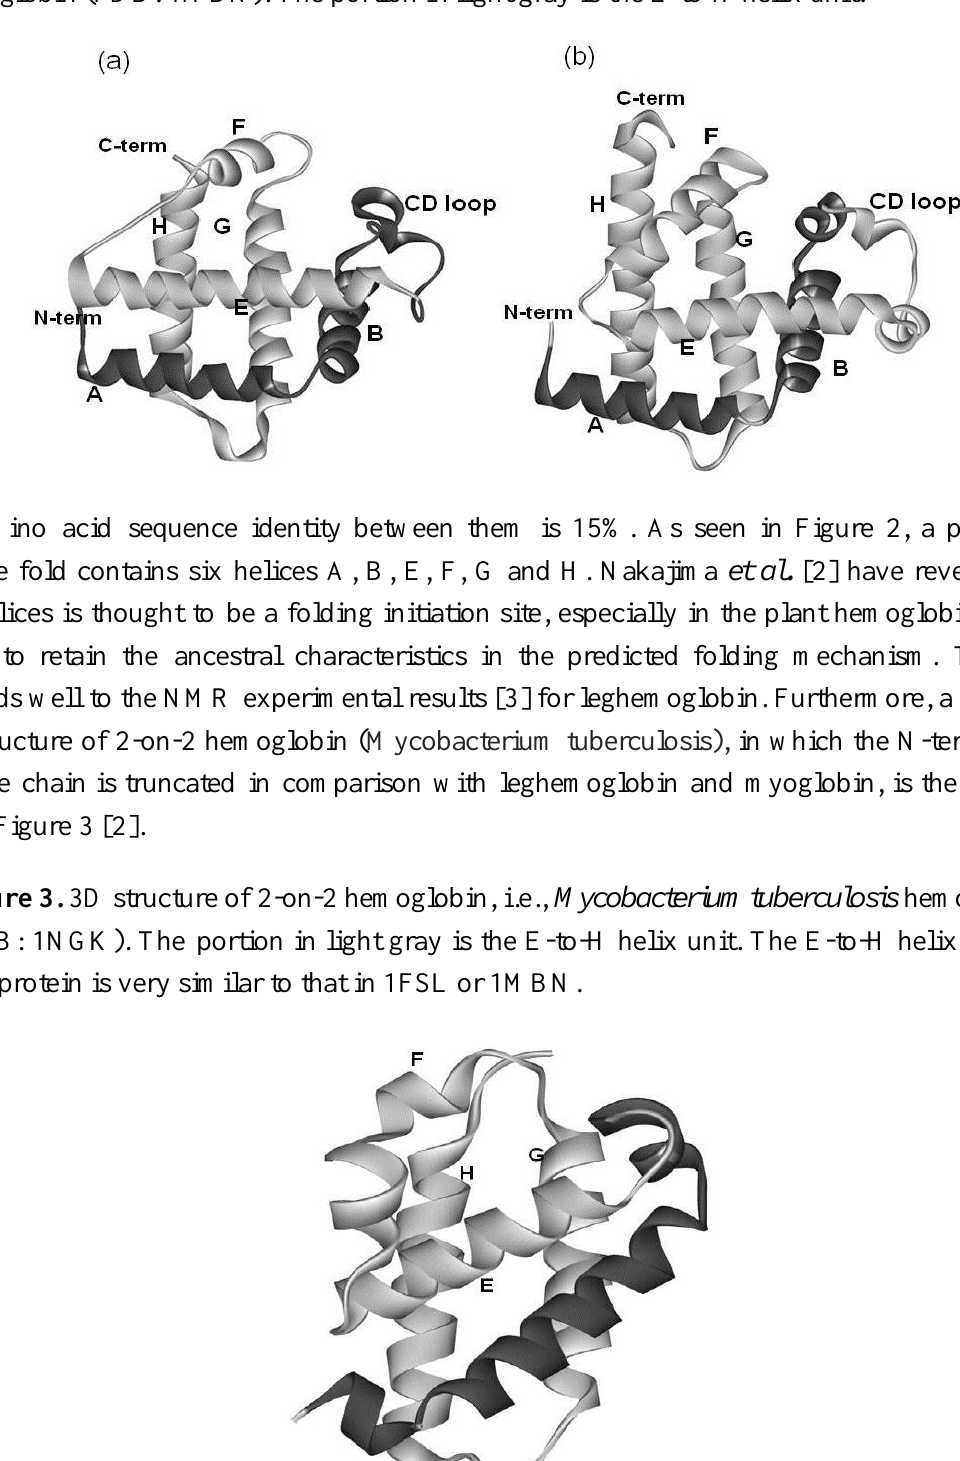
Figure 2. 3D structures of ( a ) soybean leghemoglobin (PDB: 1FSL) and ( b ) sperm whale myoglobin (PDB: 1MBN). The portion in light gray is the E-to-H helix unit.